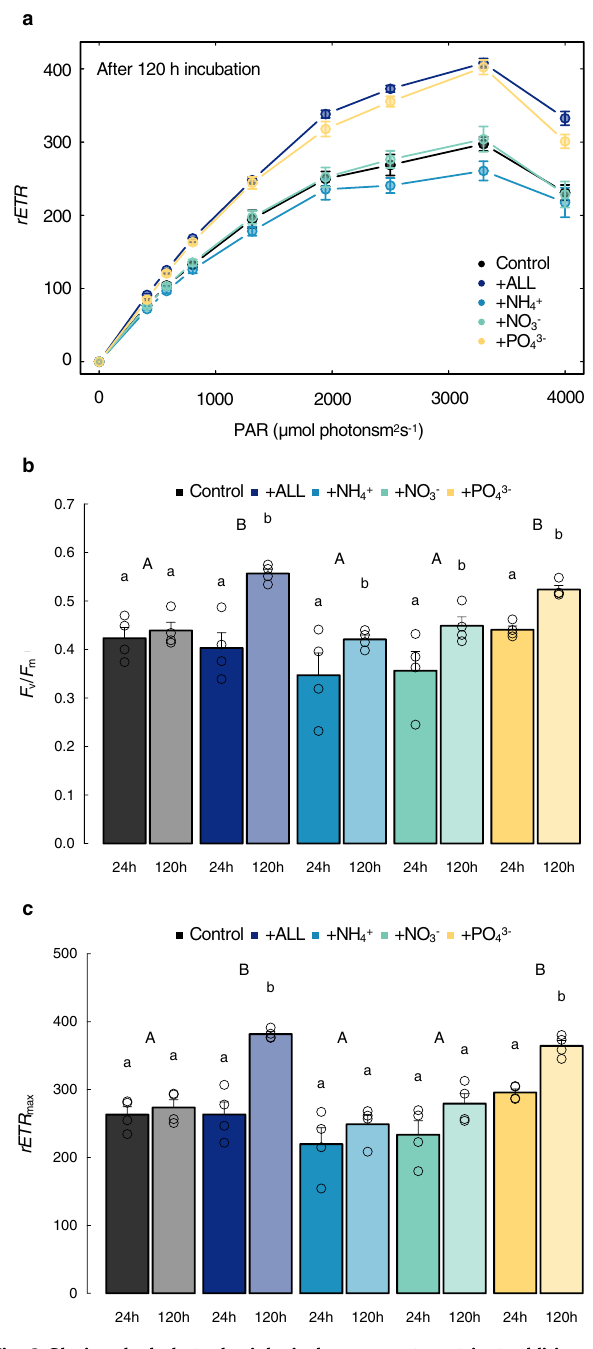
Fig. 2 Glacier algal photophysiological response to nutrient addition. a Relative electron transport rates ( rETR ) measured during rapid light curves (RLCs) following 120 h incubation, b maximum quantum ef fi ciency in the dark-adapted state ( F v / F m ) and c maximum electron transport rate ( rETR max ) after 24 and 120 h incubation. All plots show mean ±SE, n = 4. b , c lower and upper case letters denote homogeneous subsets identi fi ed from two-way ANOVA analysis of respective parameters in relation to duration and nutrient treatment, respectively. Two-way ANOVA results comparing treatments: F 4,30 = 6.48, P = 0.000699, and time points (24 vs 120 h): F 4,30 = 28.75, P = 0.00000839 for F v / F m . Two-way ANOVA results comparing treatments: F 4,30 = 16.71, P = 0.000000264, and time points: F = 35.07, P = 0.00000174 for rETR 4,30 max . The results of Tukey HSD tests comparing F v / F m and rETR max results for treatments at 24 and 120 h can be found in Supplementary Tables 2 and